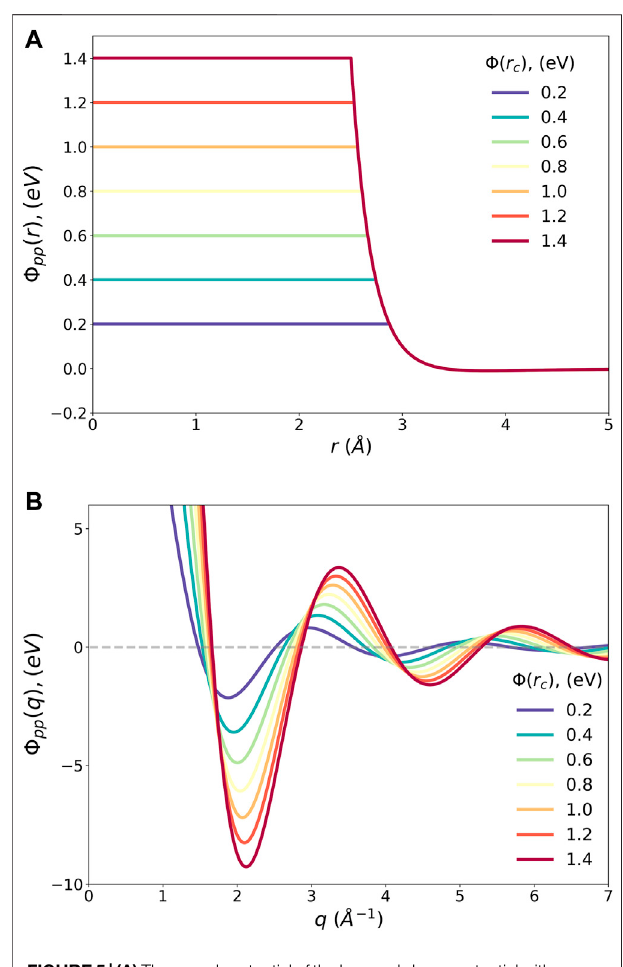
FIGURE5|(A) ThepseudopotentialoftheLennard-Jonespotentialwith various cut-off levels, ϕ pp ( r ), and (B) their Fourier transforms, ϕ pp ( q ).